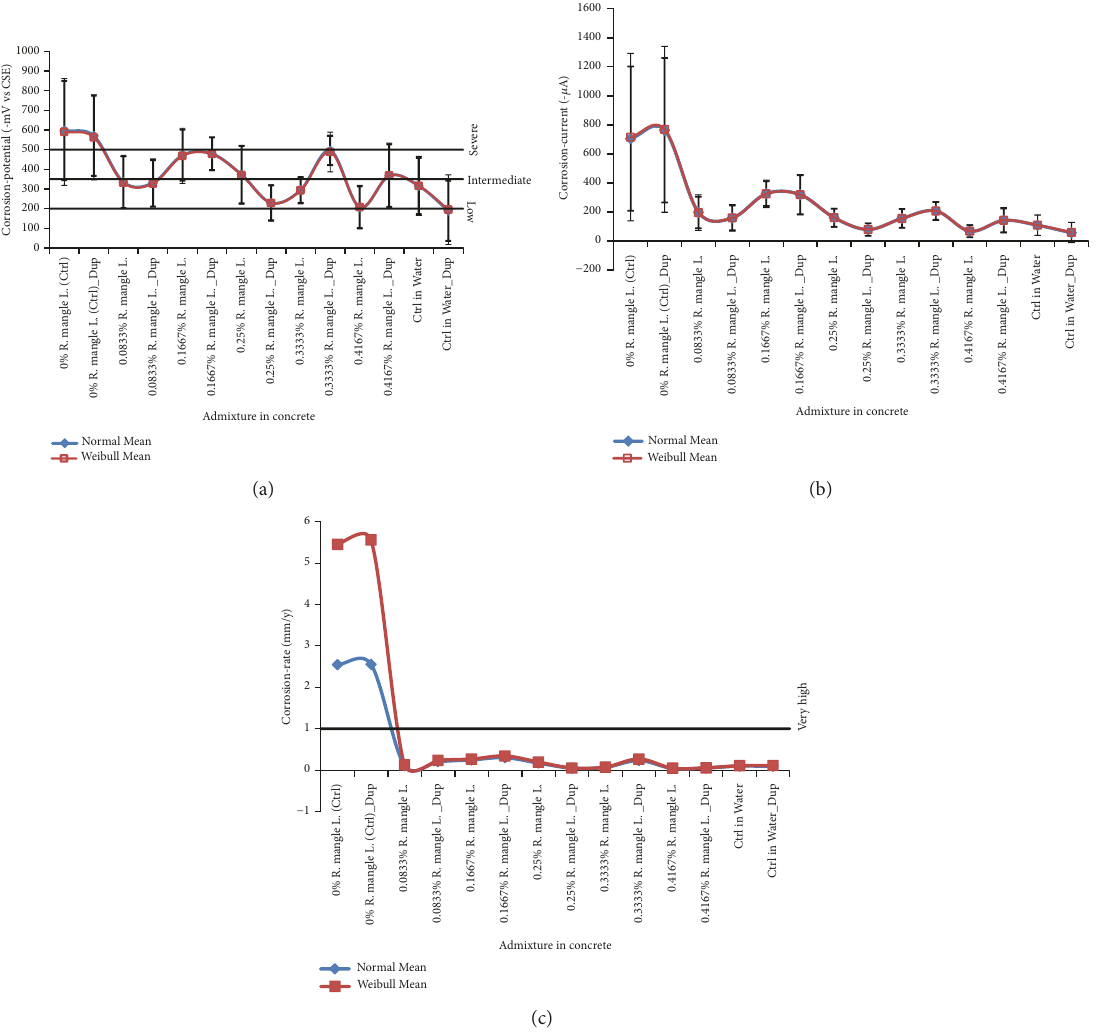
Figure 1: Plots of analysed results from the statistical distribution fitting models of corrosion test-variables: (a) corrosion-potential ( CP ) in mean ± standard deviation ranges with line graphs of corrosion risks criteria according to ASTM C876–15 [78]; (b) corrosion-current ( CC ) in mean ± standard deviation ranges; (c) corrosion-rate ( CR ) in mean values with a line graph of corrosion criteria